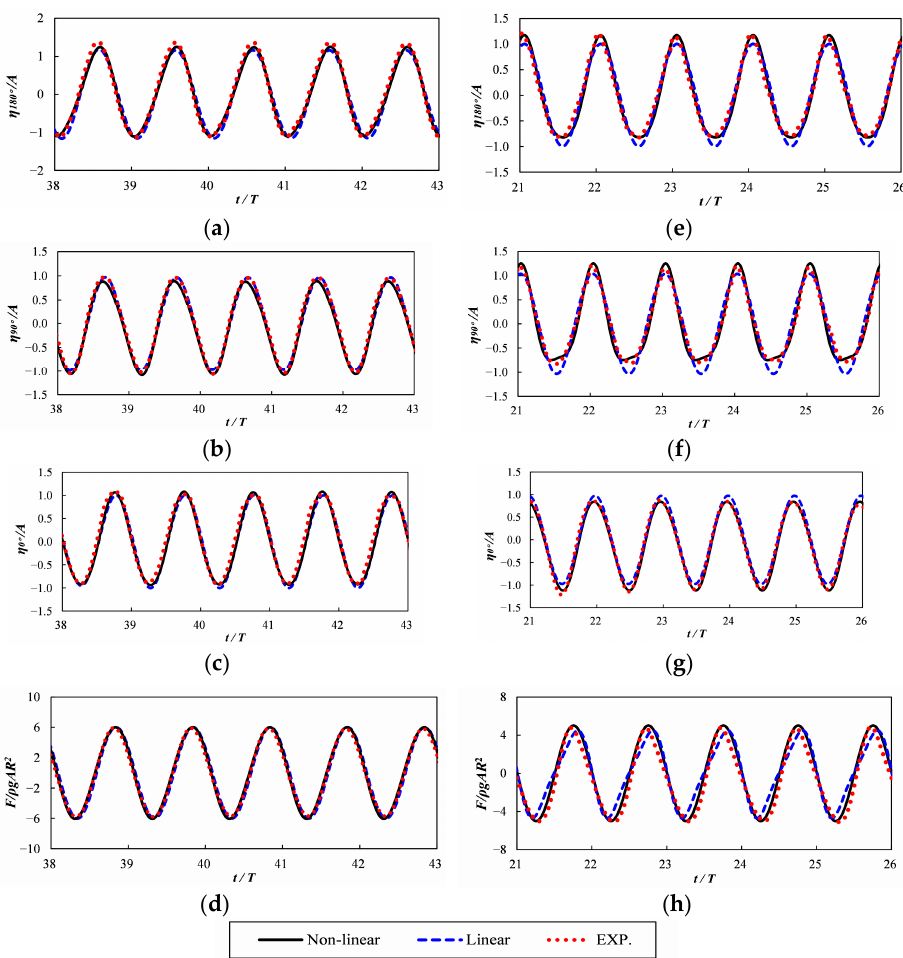
Figure 5. Time series of the simulated and measured run-up around the monopile and wave load on the monopile: ( a ) run-up at the front point in Case 1, ( b ) run-up at the shoulder point in Case 1, ( c ) run-up at the back point in Case 1, ( d ) horizontal wave load in Case 1, ( e ) run-up at the front point in Case 2, ( f ) run-up at the shoulder point in Case 2, ( g ) run-up at the back point in Case 2, and ( h ) horizontal wave load in Case 2.